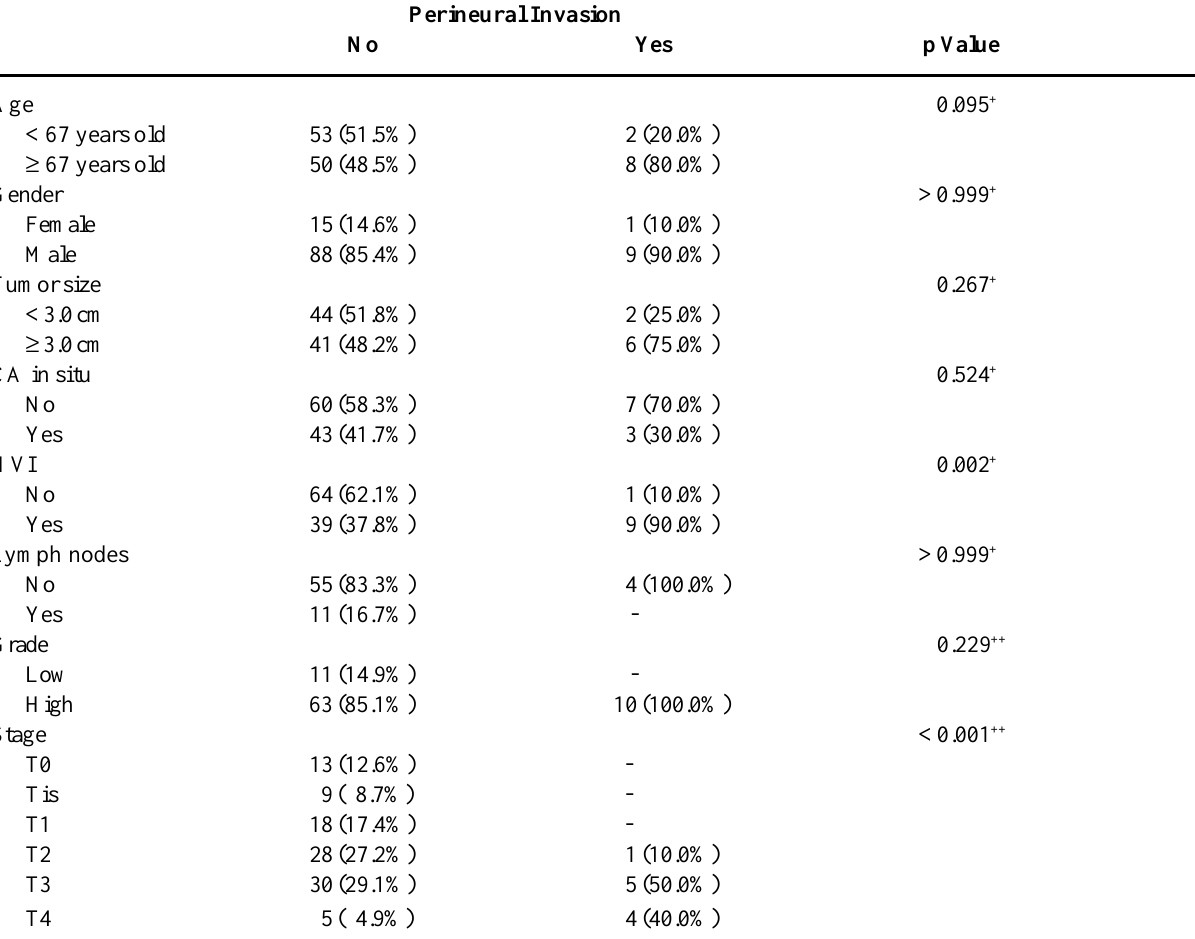
Table 1 – Patients’ characteristics according to perineural